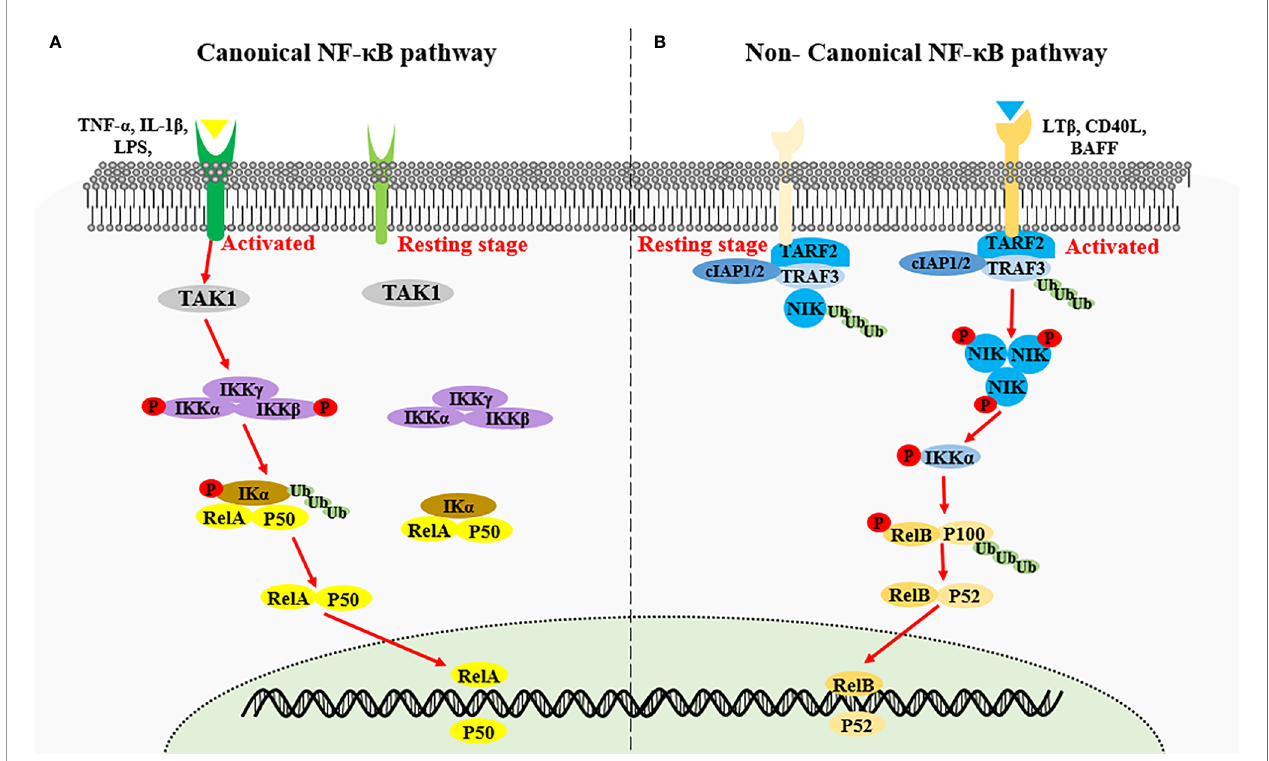
FIGURE 1 | Activation of canonical NF- k B signaling and non-canonical NF- k B signaling. (A) Canonical NF- k B signaling is stimulated by proin fl ammatory cytokines such as IL-1 b , TNF- a and LPS, inducing the activation of IKK complex by TAK1. The IKK complex then phosphorylates the I k B kinase a / b (IKK a / b ), causing the ubiquitin-dependent degradation of k B inhibitory factors (I k Bs) protein, thereby triggering the nuclear transcription factor heterodimer RelA/p50. (B) Non-canonical NF- k B signaling is activated by the speci fi c TNFR superfamily. Receptor activation induce the recruitment of TRAF3-TRAF2-cIAP1/2 receptor complex, followed by the degradation of TRAF3 via ubiquitination, resulting in the stabilization and accumulation of NIK. NIK phosphorylates IKK a which in turn phosphorate p100, triggering the ubiquitination and degradation of p100 to generate p52 and the nuclear transduction of RelB-p52